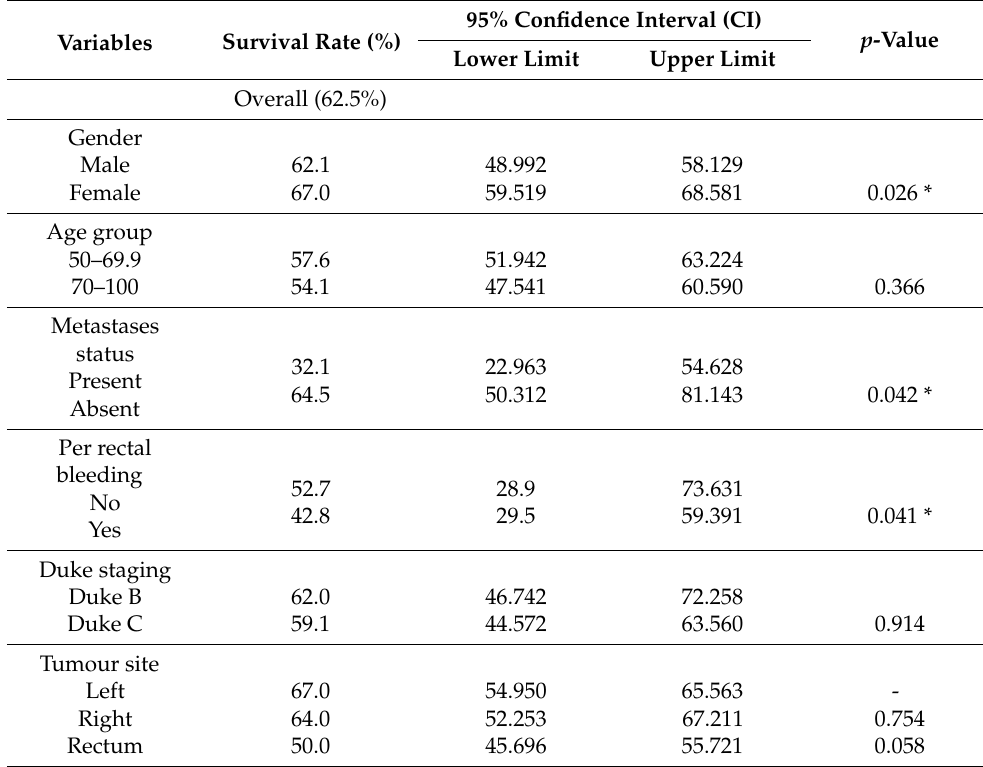
Table 4. The 5-year survival proportion performed using Kaplan–Meier